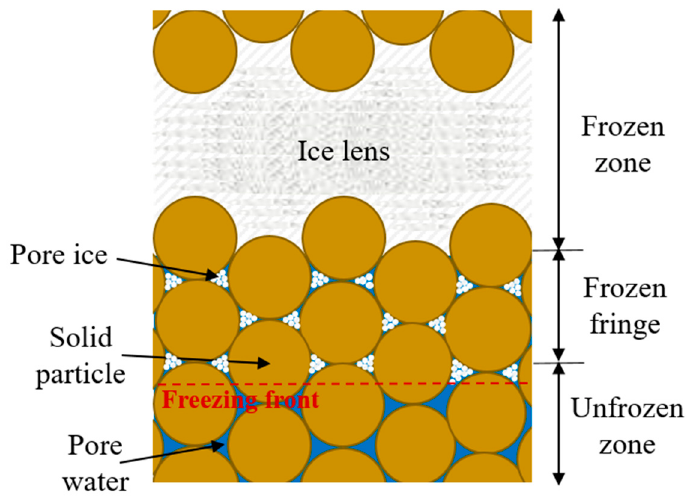
Figure 3. Schematic representation of a frozen soil (Reproduced from [2]).